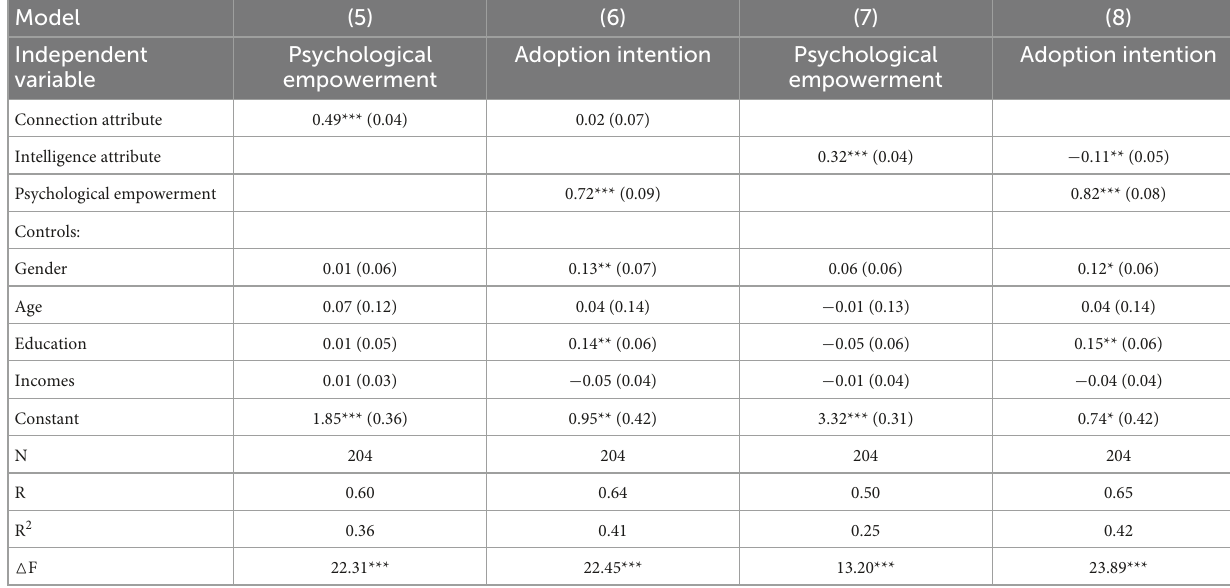
TABLE 4 Mediator effect regression